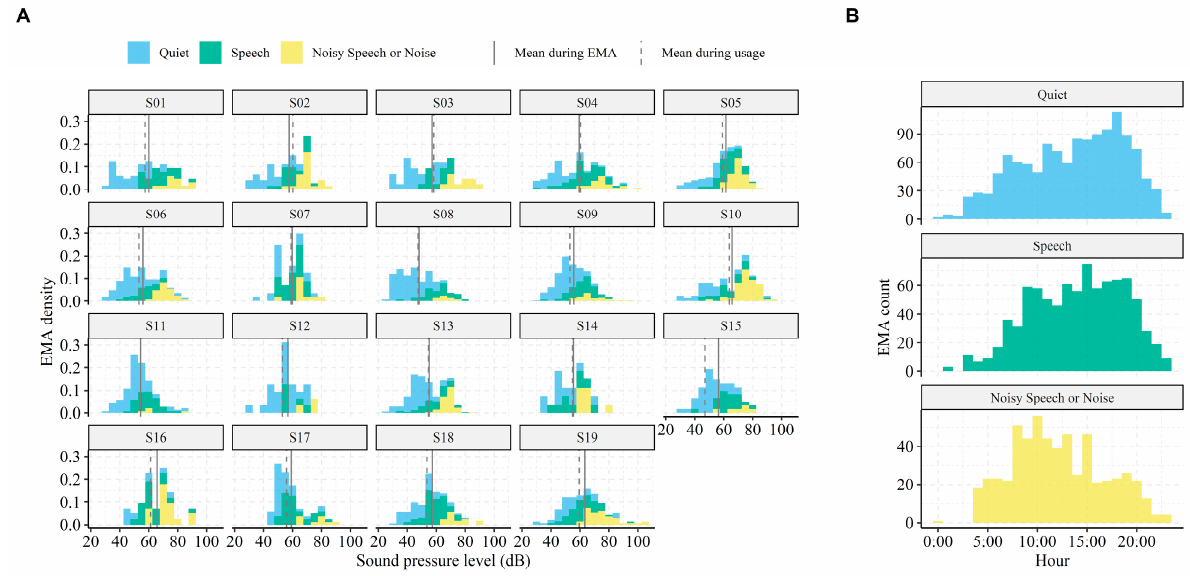
Figure 2. Data logging summary. ( A ) Density distributions of the sound pressure levels during Ecological Momentary